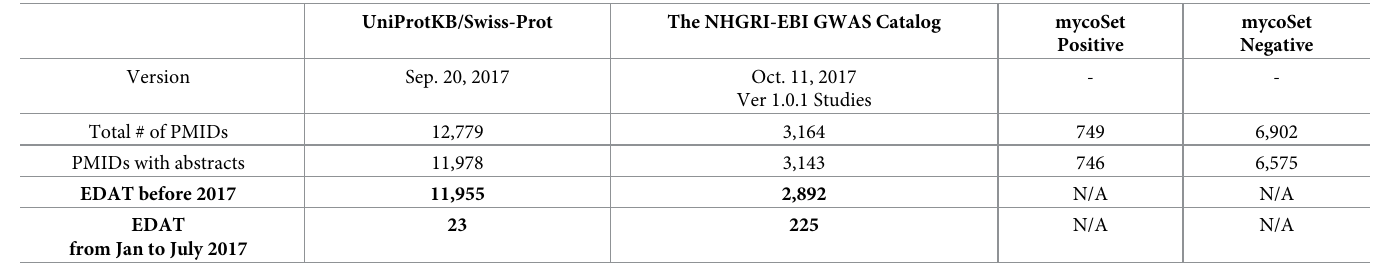
Table 4. Statistics of the